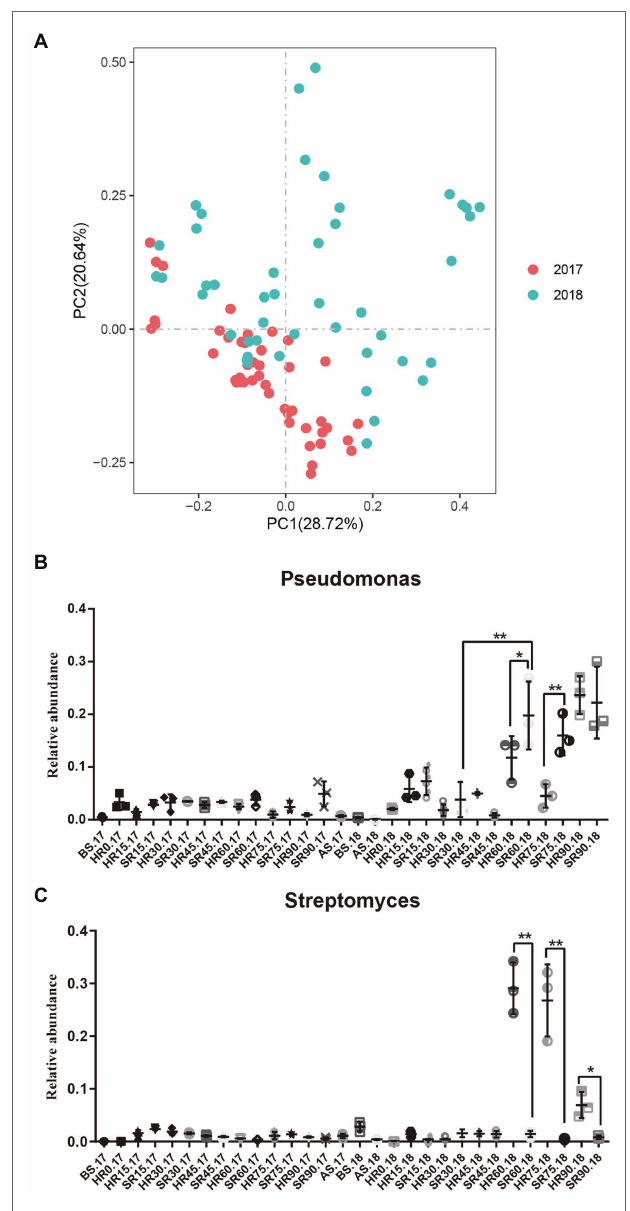
FIGURE 5 | Comparison of root microbial composition after RKN infection in different planting years. (A) The distribution and composition of rhizosphere bacteria in 2017 and 2018 analyzed by PCoA based on a weighted UniFrac algorithm. (B,C) The relative abundances of Pseudomonas and Streptomyces in rhizosphere bacteria. Data were analyzed by ANOVA (* p < 0.05 and ** p <